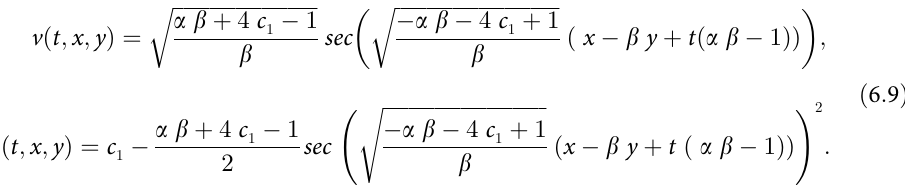
ffiffiffiffiffiffiffiffiffiffiffiffiffiffiffiffiffiffiffiffiffiffiffiffiffiffiffiffi a b þ 4 c